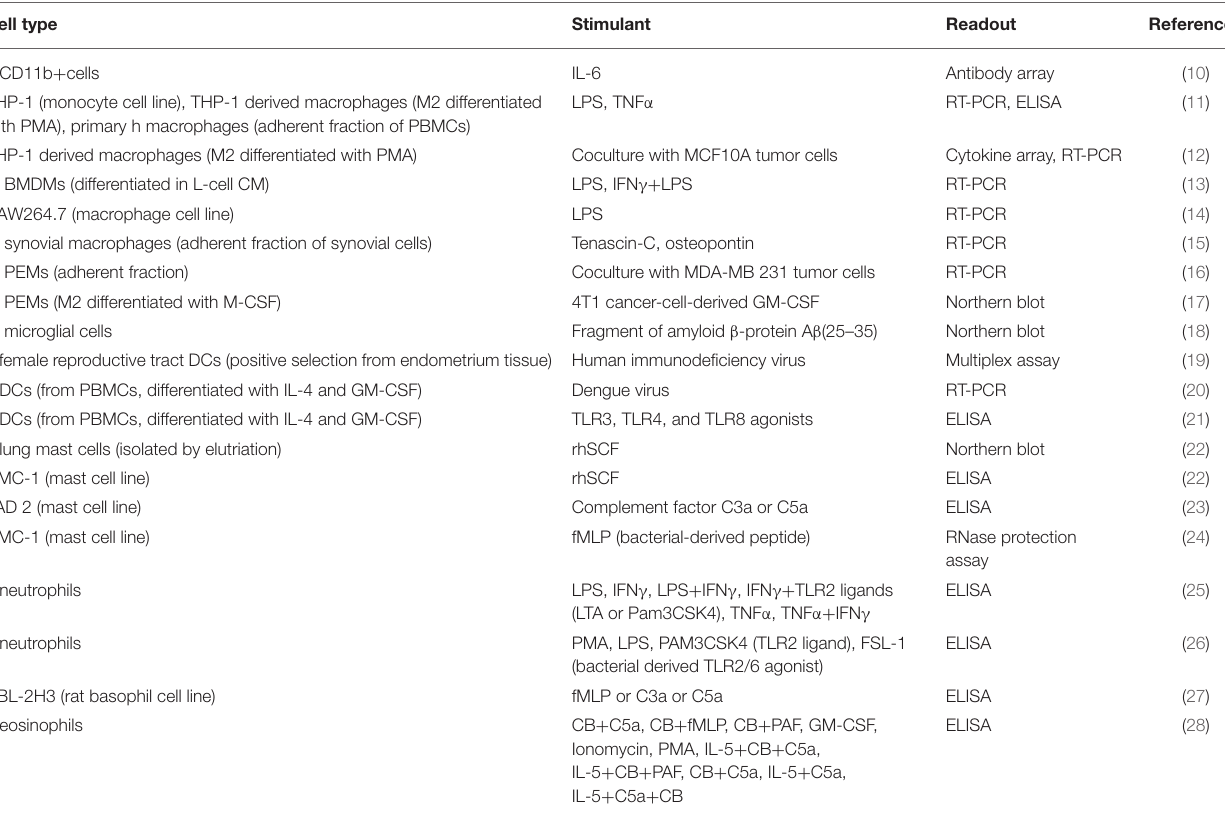
TABLE 1 | Expression of CCL2 by myeloid